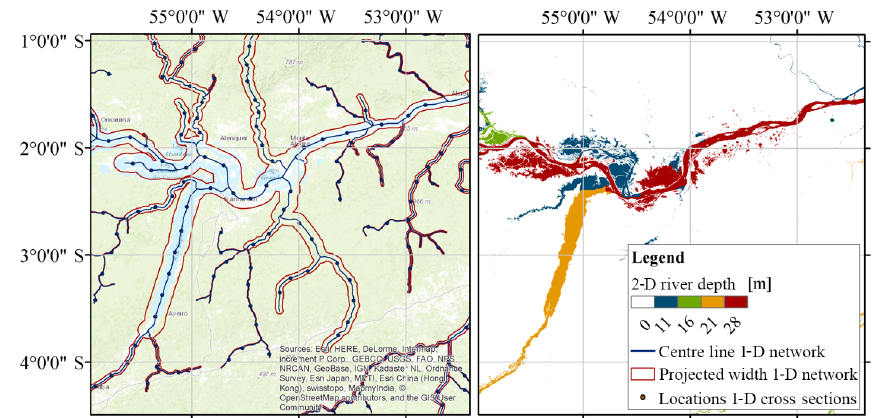
Figure 2. The 1-D network centre line and cross sections, as well as its computed (projected) width and computed river depth for all cells defined as permanent water bodies in G3WBM for the same